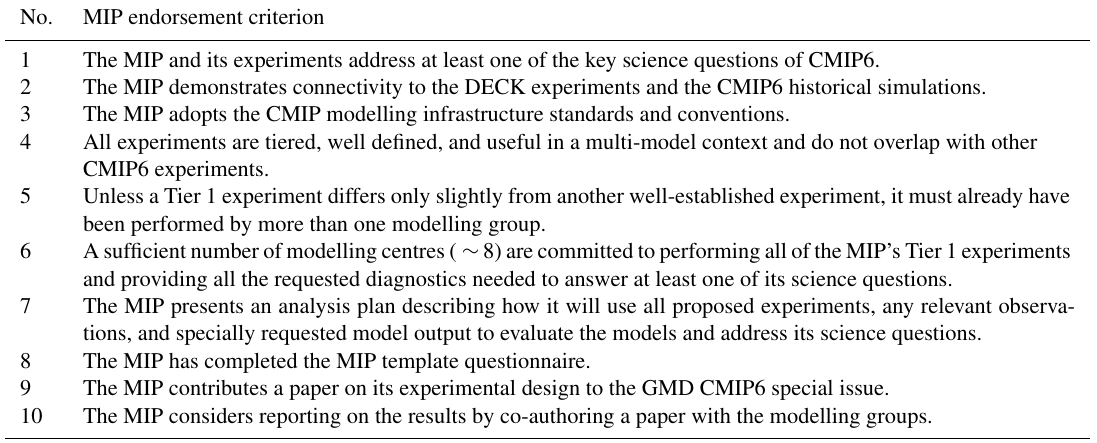
Table 1. Main criteria for MIP endorsement as agreed with representatives from the modelling groups and MIPs at the WGCM 18th Session in Grainau, Germany in October